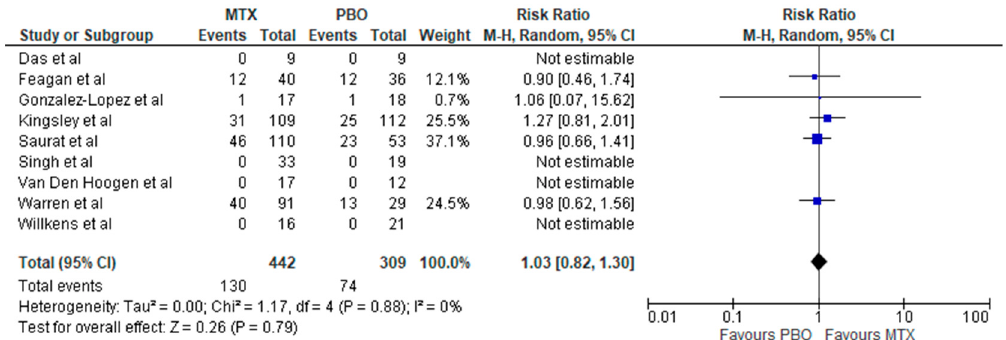
Figure 5. Forest plot: Risk of infection of methotrexate therapy in non-RA inflammatory diseases. (Studies included: [27,28,30,31,33,34,36,37,39])